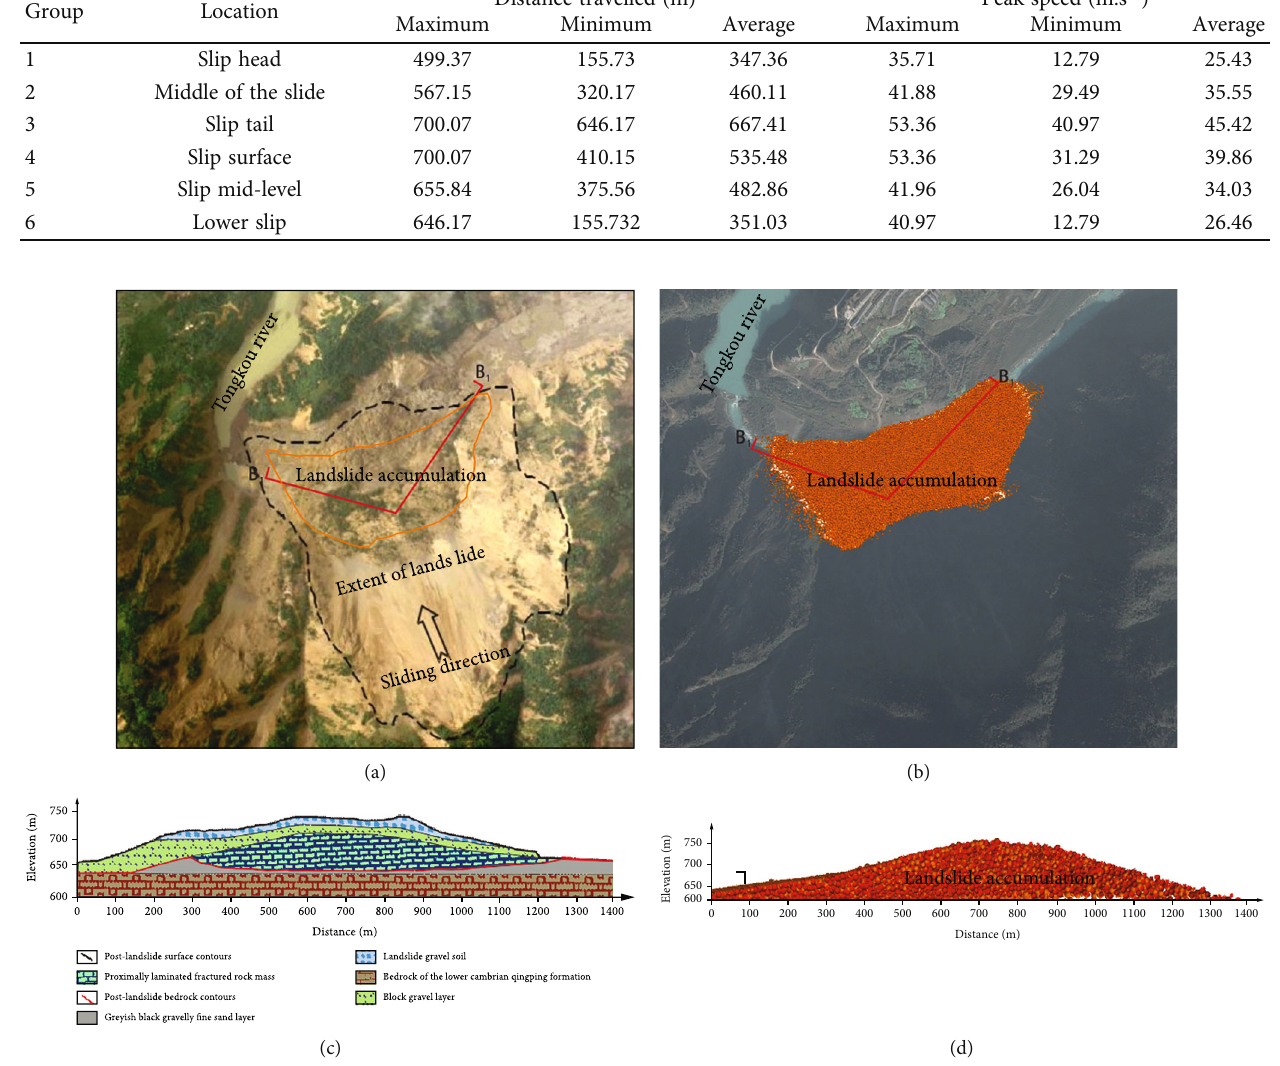
Figure 12: Comparison of landslide accumulations [29]. (a) Postlandslide satellite imagery. (b) Numerical simulation of the top view of the stack. (c) Geological section of the weir B